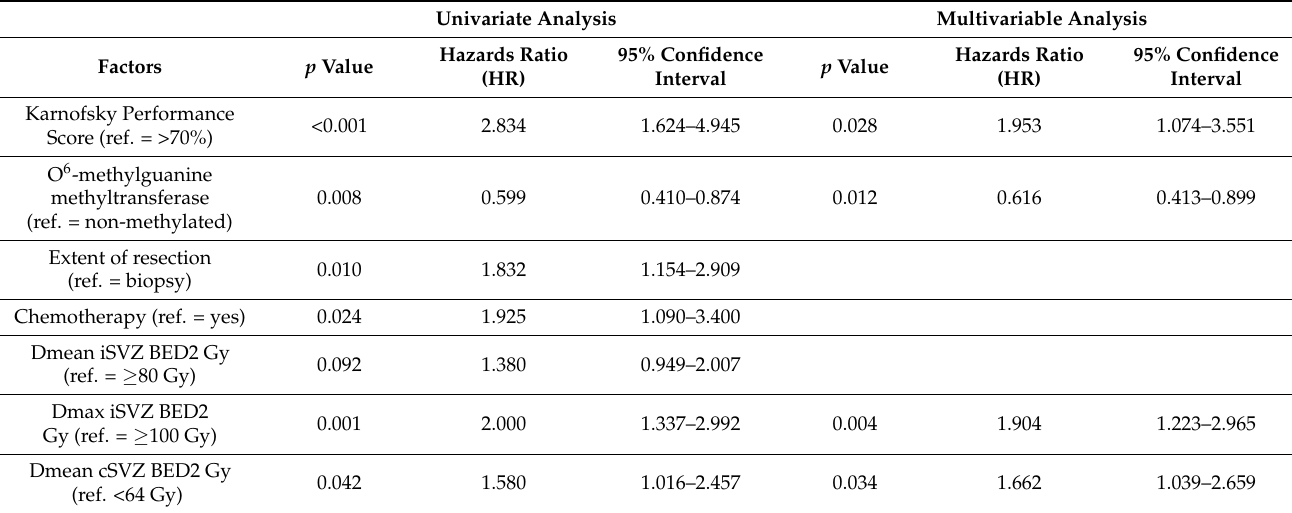
Table 2. Prognostic factors for PFS.